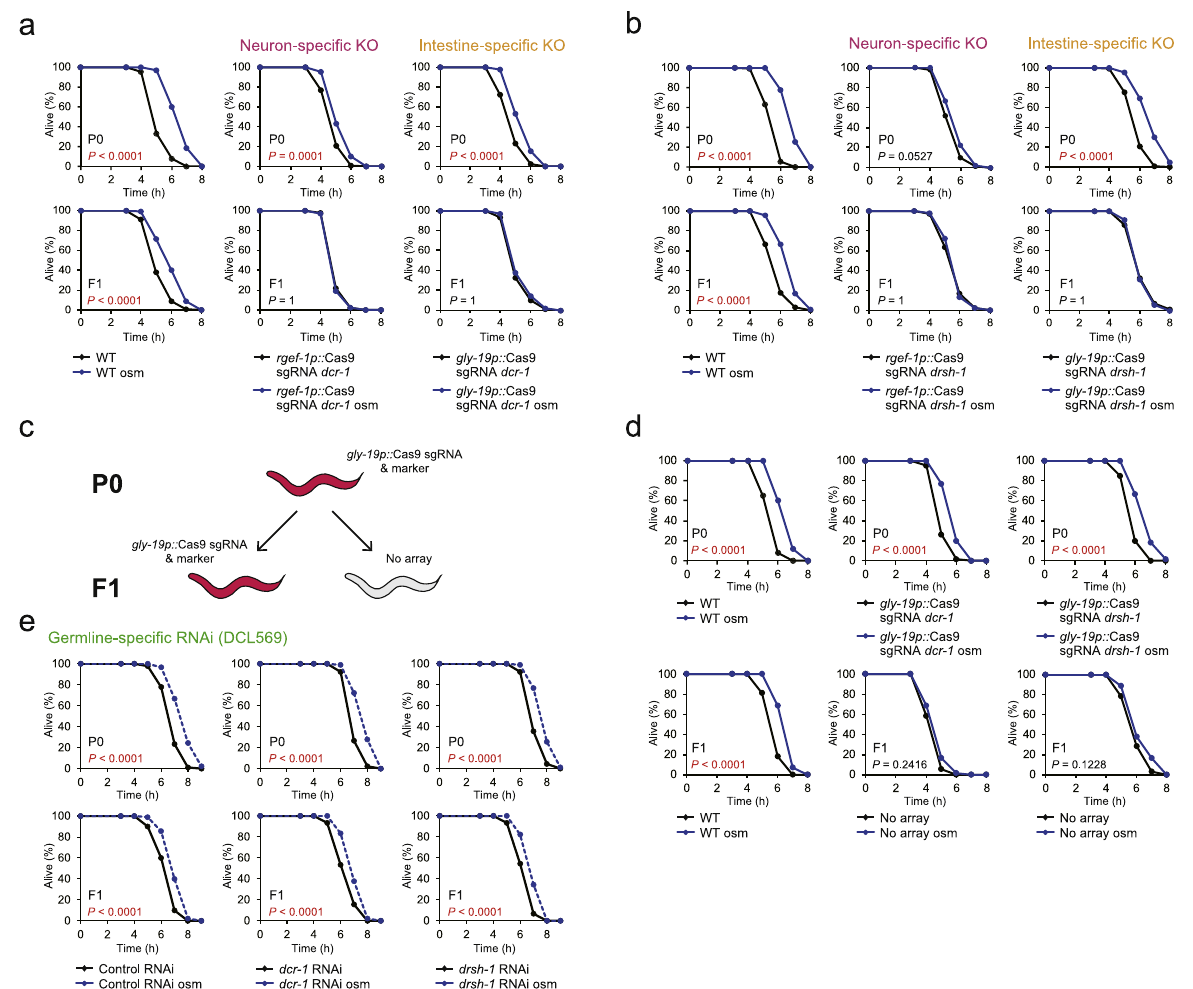
Fig. 4 Production of miRNAs in the neuron and intestine is necessary for the inheritance of hormesis. a Oxidative stress resistance (1.8 mM H 2 O 2 ) of WT (left), neuron-speci fi c dcr-1 -knockout mutants (middle) and intestine-speci fi c dcr-1 -knockout mutants (right) in the P0 generation (upper) and the F1 generation (lower). b Oxidative stress resistance of WT (left), neuron-speci fi c drsh-1 -knockout mutants (middle), and intestine-speci fi c drsh-1 -knockout mutants (right) in the P0 generation (upper) and the F1 generation (lower). c Scheme for obtaining the descendants (no array) from intestine-speci fi c knockout worms. The descendants (no array) were distinguished by the loss of a mCherry fl uorescent coinjection marker. d Oxidative stress resistance of WT (left), intestine-speci fi c dcr-1 -knockout mutants (middle), and intestine-speci fi c drsh-1 -knockout mutants (right) in the P0 generation (upper) and in the F1 generation (no array) (lower). e Oxidative stress resistance (2.0 mM H 2 O 2 ) of germline-speci fi c RNAi mutants (DCL569) treated with RNAi (left, control RNAi; middle. dcr-1 RNAi; right, drsh-1 RNAi) in the P0 generation (upper) and the F1 generation (Lower). Two or three independent experiments are distinguished into each survival curve ( n = 60 or 90). Mean survival time and statistics are presented in Supplementary Data 1. P values were calculated by log-rank test with Bonferroni